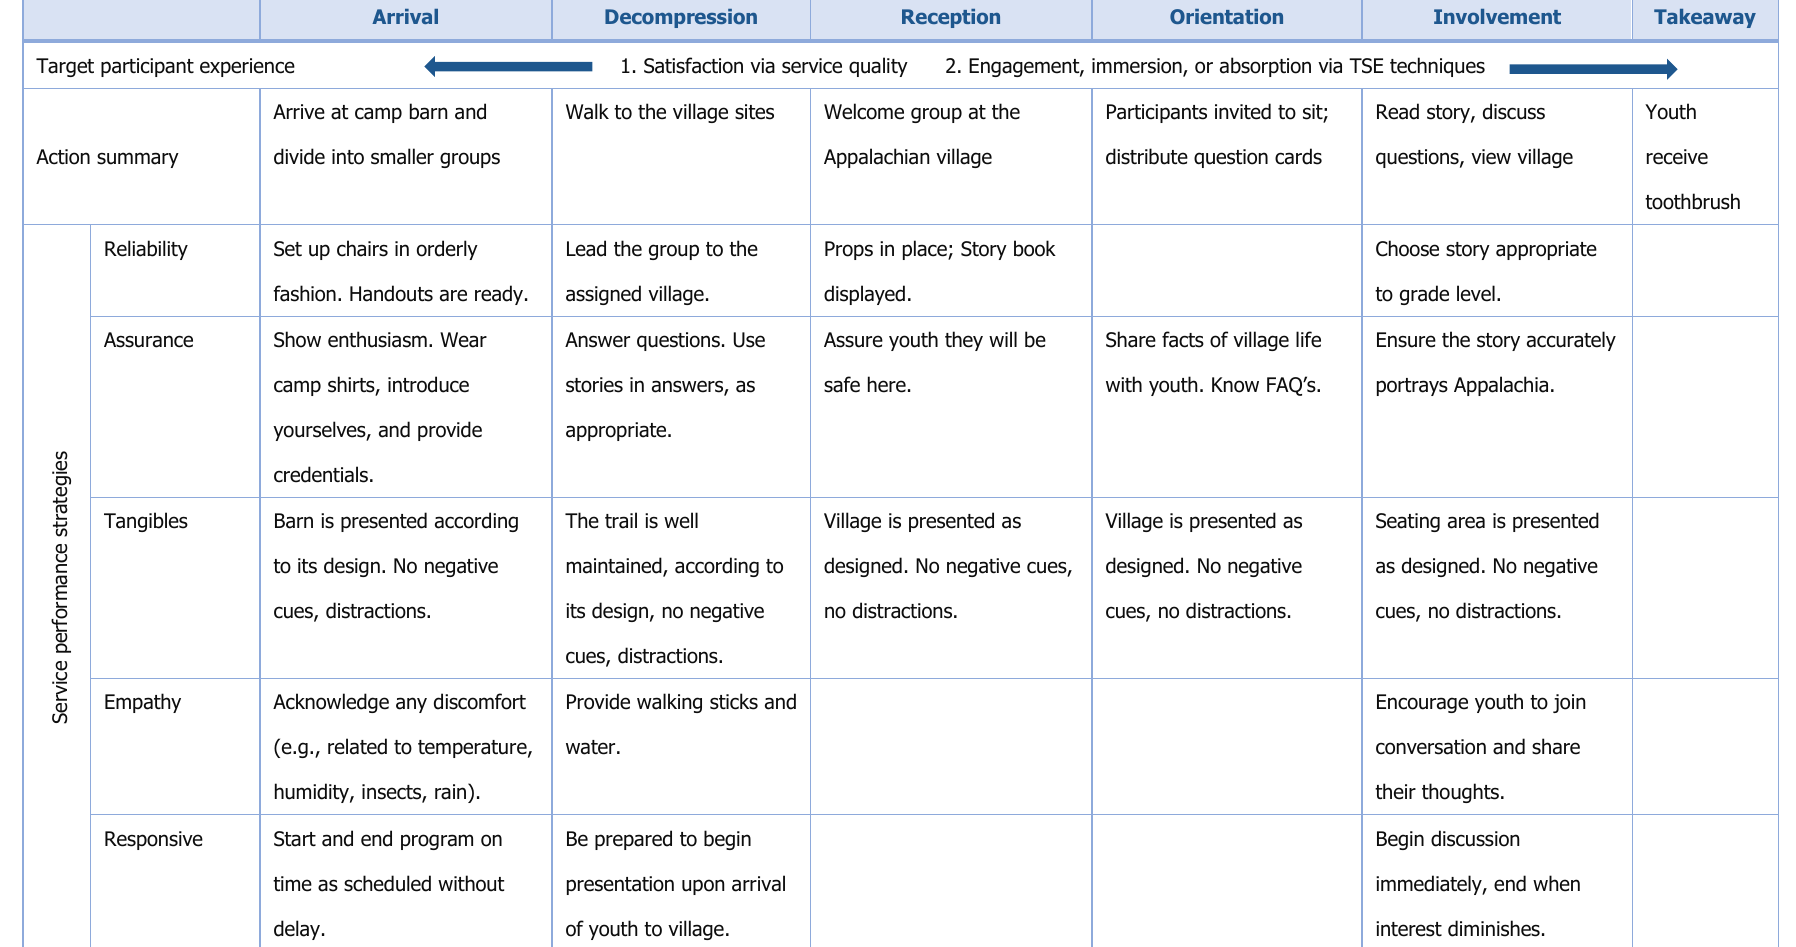
Table 3. Experience Journey Map: Engagement and Immersion